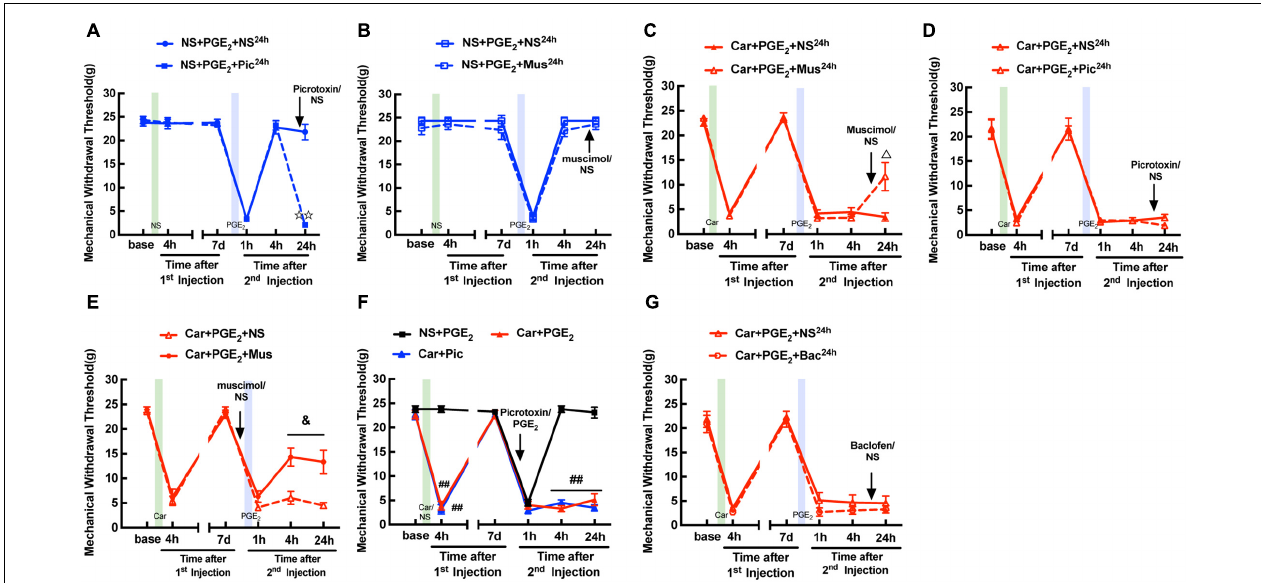
FIGURE 2 | Function of GABAAR in the L4-L6 DRGs is not changed in hyperalgesic priming model. (A) Picrotoxin (1 µ M/25 µ L/paw) injection at 24 h after the 2nd injection significantly decreased the MWT of sham hyperalgesic priming rats. (B) Muscimol (10 µ M/25 µ L/paw) injection at 24 h after the 2nd injection produced little effect on MWT of sham hyperalgesic priming rats. (C) Muscimol injection at 24 h after 2nd injection significantly increased the MWT of hyperalgesic priming rats. (D) Picrotoxin injection at 24 h after the 2nd injection produced little effect on MWT of hyperalgesic priming rats. (E) MWT of hyperalgesic priming rats that received Muscimol injection 10 min before the PGE 2 injection. (F) MWT of rats that received Picrotoxin injection following by carrageenan. (G) Baclofen (60 µ g/25 µ L/paw) injection at 24 h after the 2nd injection failed to affect the MWT of hyperalgesic priming rats. All Data are presented as mean ± SEM, n = 6 rats per group; P < 0.01 vs. NS + PGE 2 + NS 24 h group, (cid:49) P < 0.05 vs. Car + PGE 2 + NS 24 h group, & P < 0.05 vs. Car + PGE 2 + NS group, ## P < 0.01 vs. NS + PGE 2 group. Student’s t -test was used to compare two independent samples; Three independent samples are according to ANOVA followed by Bonferroni post hoc